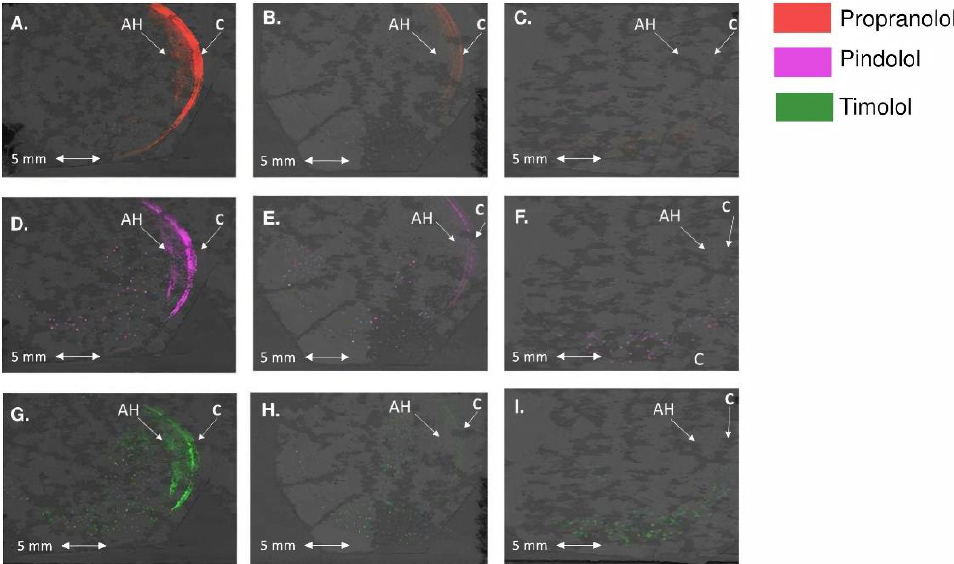
Figure 6. Distribution of ( A ) propranolol at 10 min, ( B ) propranolol at 60 min, ( C ) blank image without propranolol, ( D ) pindolol at 10 min, ( E ) pindolol at 60 min, ( F ) blank image without pindolol, ( G ) timolol at 10 min, ( H ) timolol at 60 min, and ( I ) blank image without timolol after eye drop administration. Drugs were seen in the cornea (C) and aqueous humor (AH). The signals were normalized using the root mean square method. Table 2. Ratios of pindolol and timolol signals against twice the signal of propranolol in rabbit corneal epithelium and stroma after eye drop application.